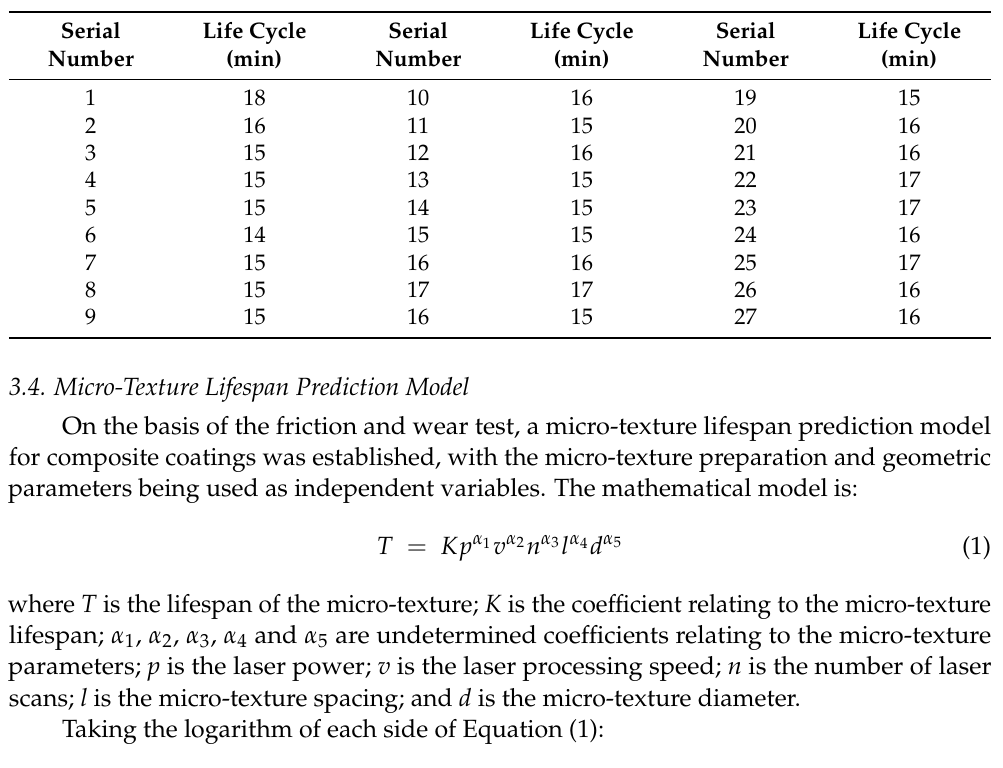
Table 4. Micro-texture life